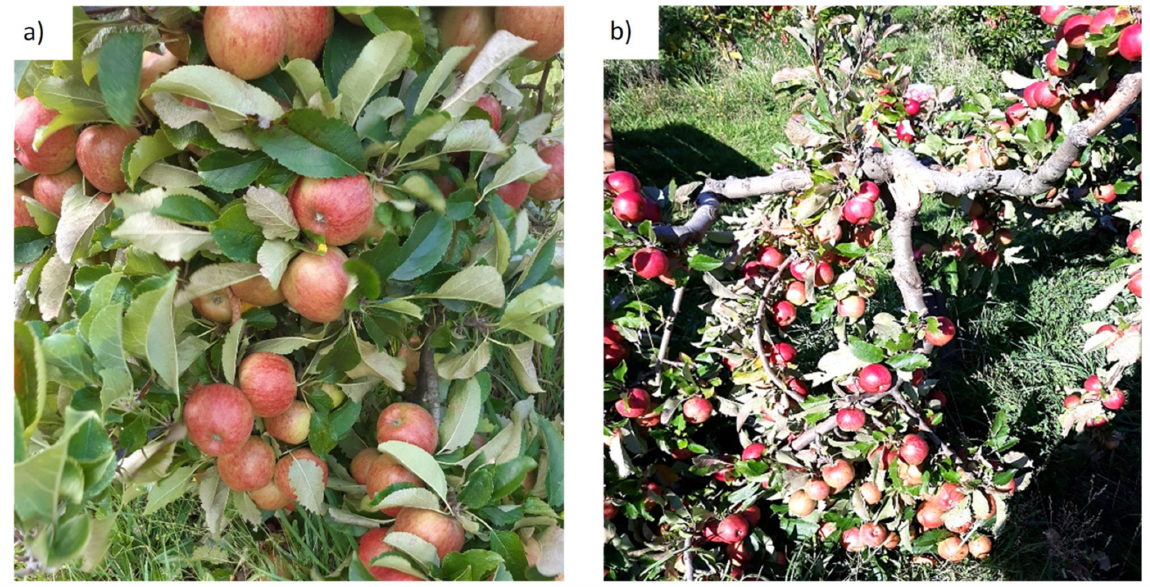
Figure 10. ( a ) Poor quality fruit. ( b ) Damage caused by high crop load (irrespective of thinning regime) during season